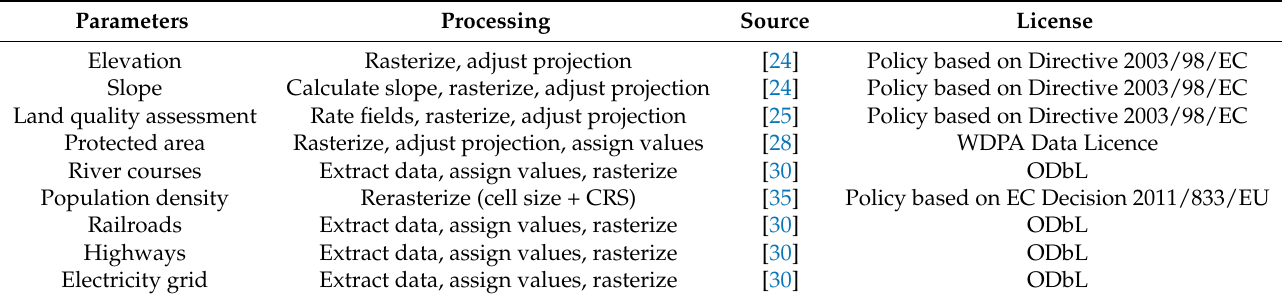
Table A1. Overview of the datasets used and a brief description of the processing steps.